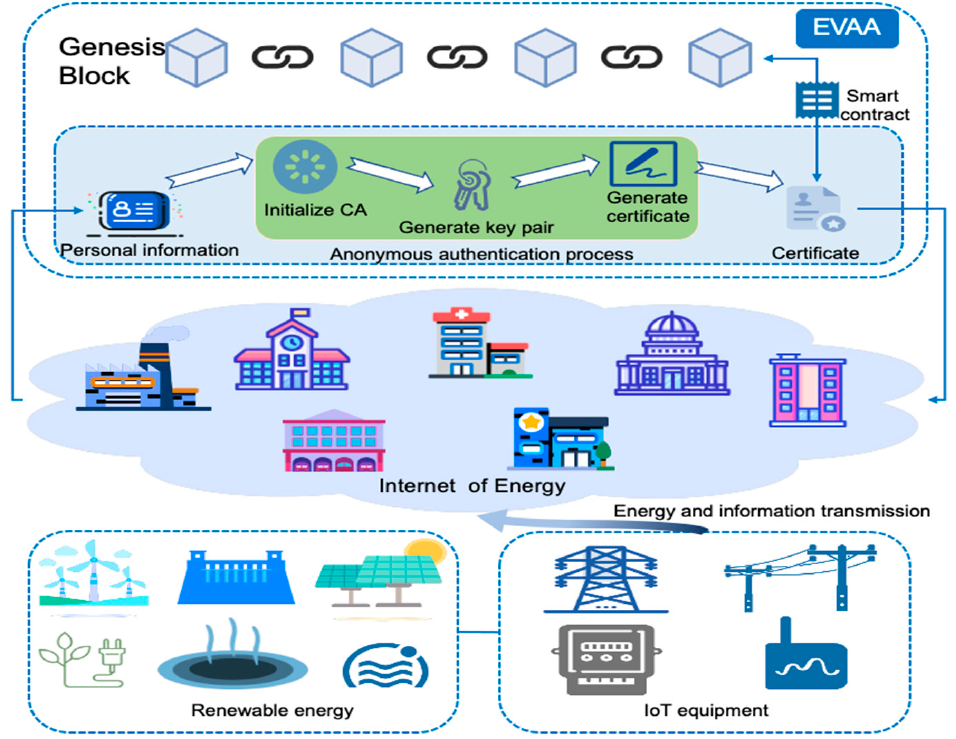
Figure 1. System architecture diagram.